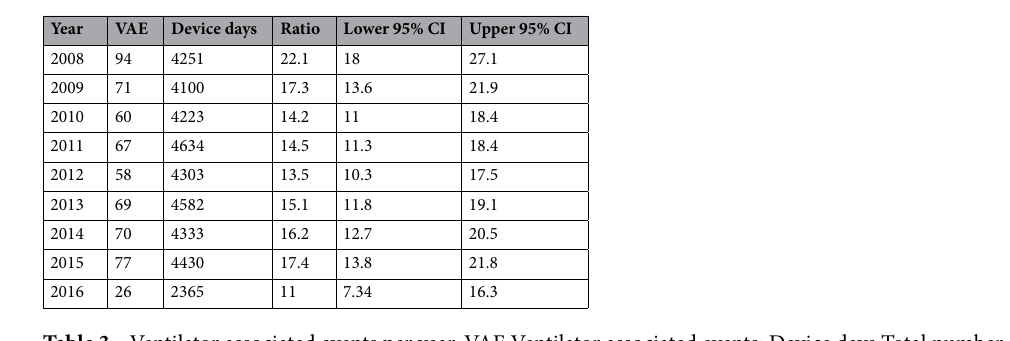
Table 3. Ventilator associated events per year. VAE Ventilator associated events; Device days Total number of ventilated patient days; CI Confidence